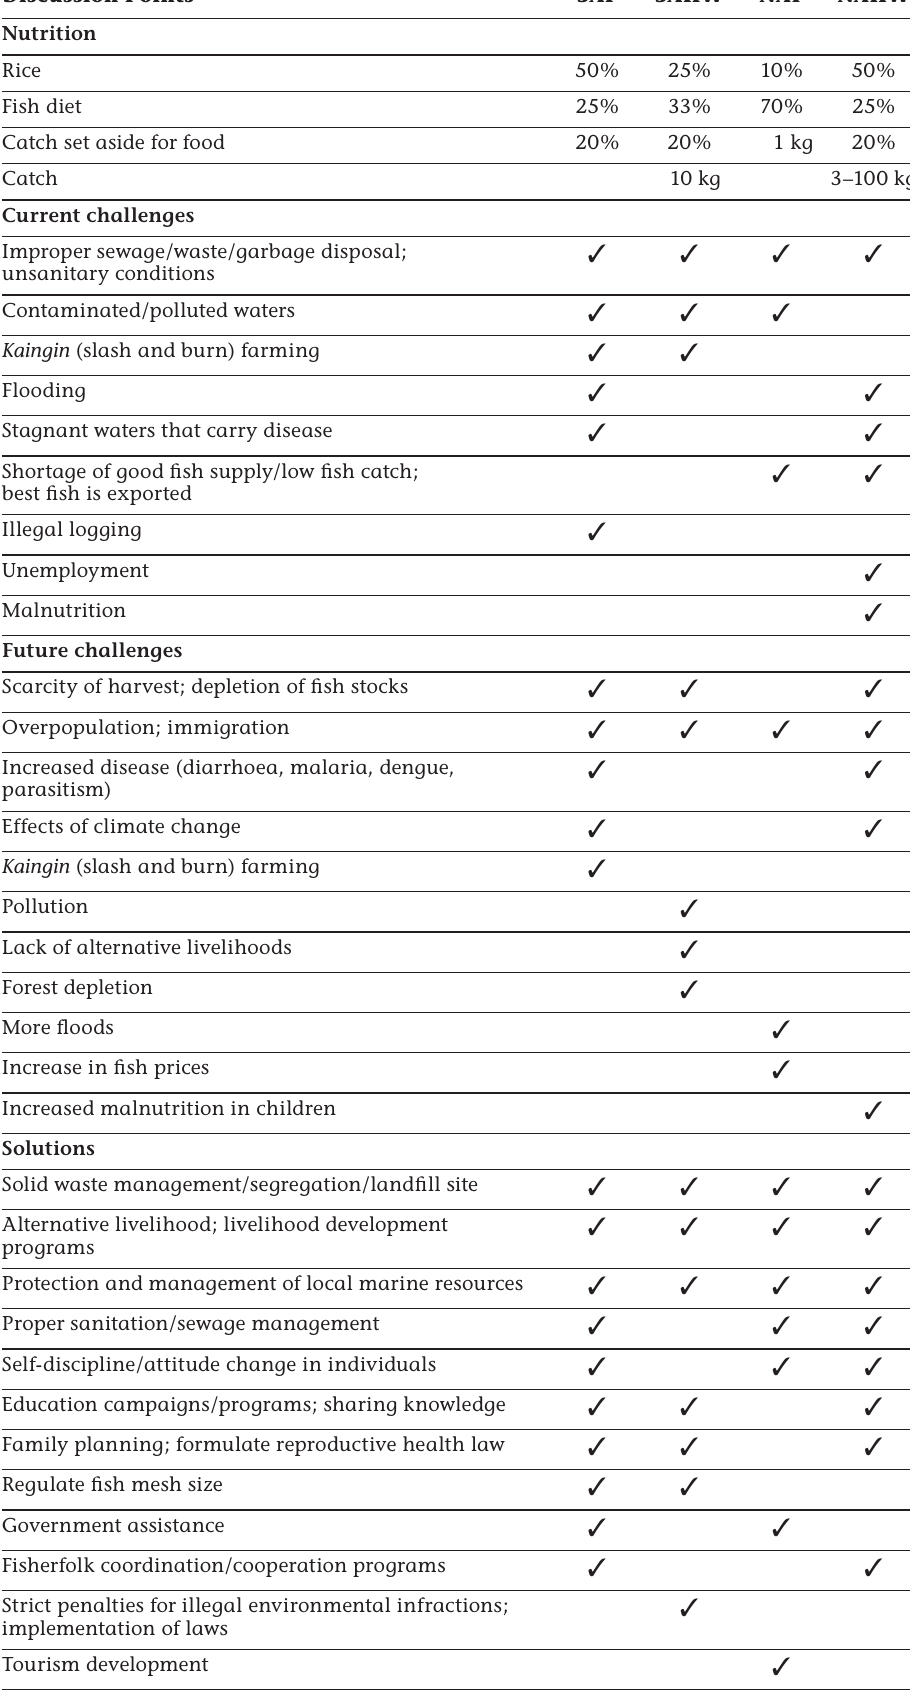
Table 1: Summary of FGD results: Southern Aurora Fisherfolk (SAF), Southern Aurora Health Workers (SAHW), Northern Aurora Fisherfolk (NAF) and Northern Aurora Health Workers